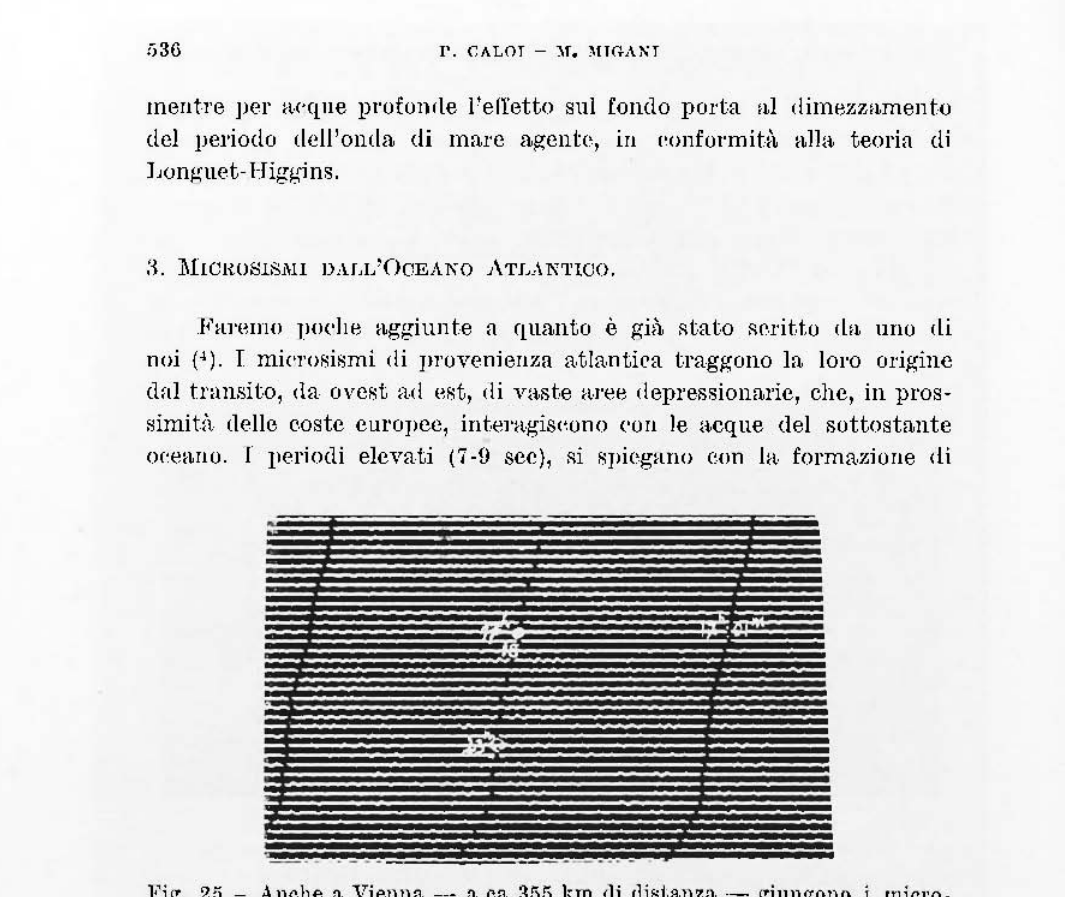
Fig. 25 - A1H'he a. Vielllla --- a. <"la 355 km di distanza·- giungono i micro· sismi, fI,f;~ocia.ti al tmnsito dol dclone (leI 15. VlI . H170 sul gulfo (li '!'riosle. COllie a Trieste. e nelle altre ~ta7.ioni d'ossorvazione, l'agitazione presonta aei m (ora. (li Greenwich), conserva il medio periodo mal\~iJlli ver~o le ISh30